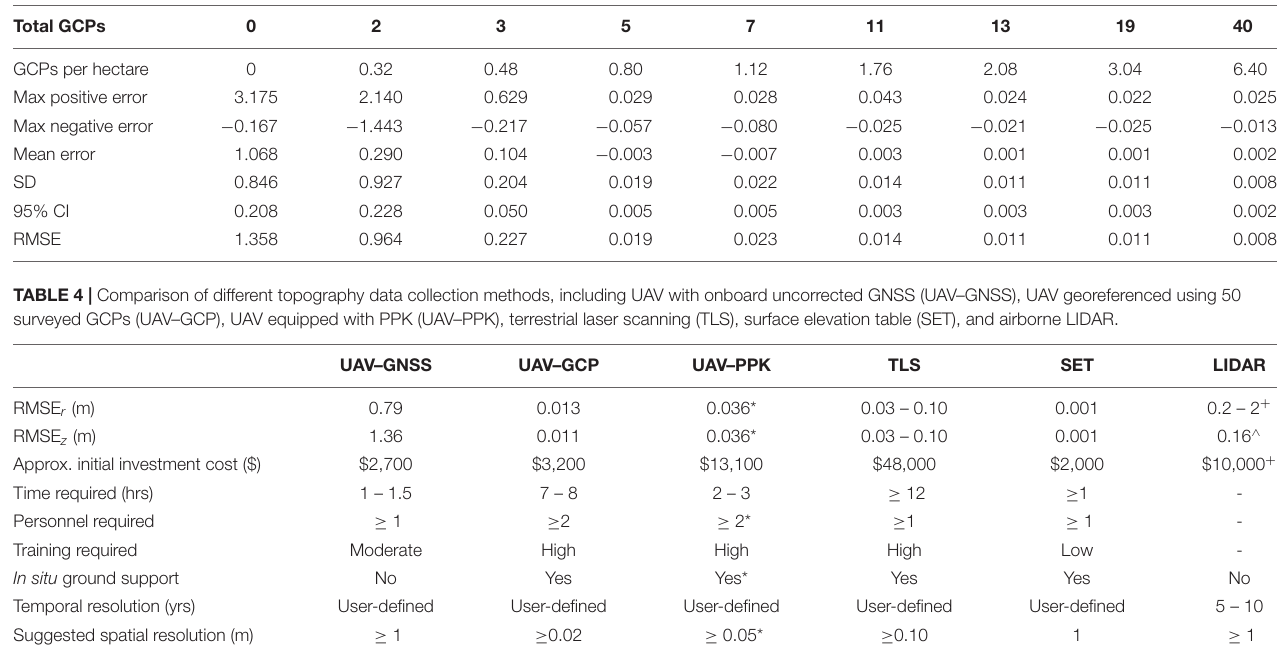
TABLE 3 | DEM vertical error for imagery collected at 50 m altitude over a 6.25-hectare area. All error values are in meters.